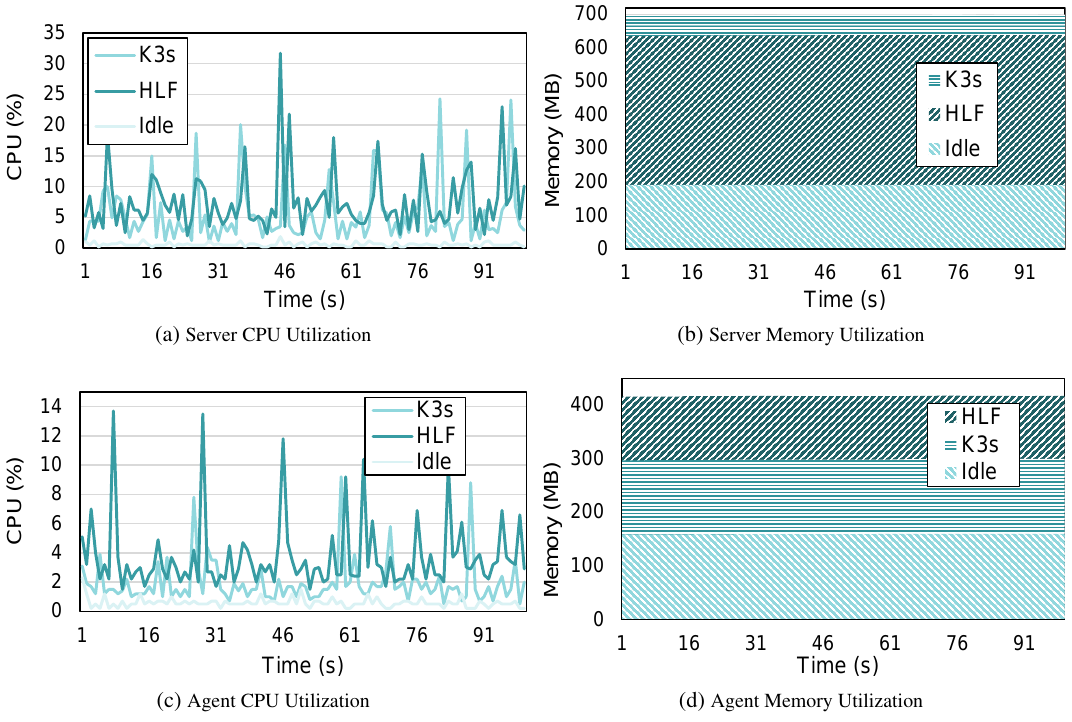
Fig. 5. Resource utilization of server and agent nodes over our step-by-step technology stack